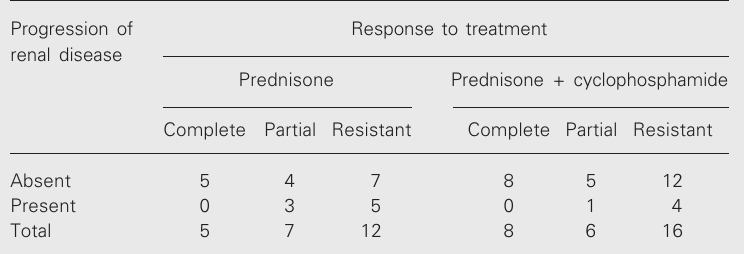
Table 4. Effect of the response to treatment on the progression of renal disease in patients with focal segmental glomerulosclerosis. Progression